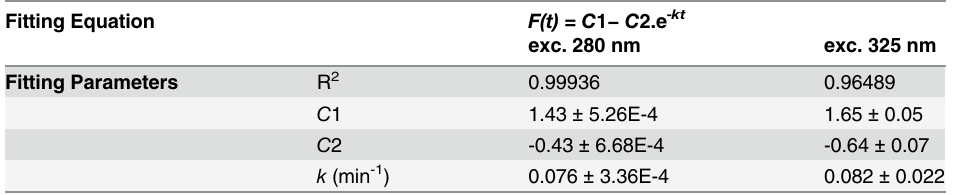
Table 5. Parameter values recovered upon fi tting the fl uorescence emission kinetic traces recorded with fi xed emission at 405 nm (exc. 280, Fig. 6B; or exc. 325 nm, Fig. 7 insert). Fitting